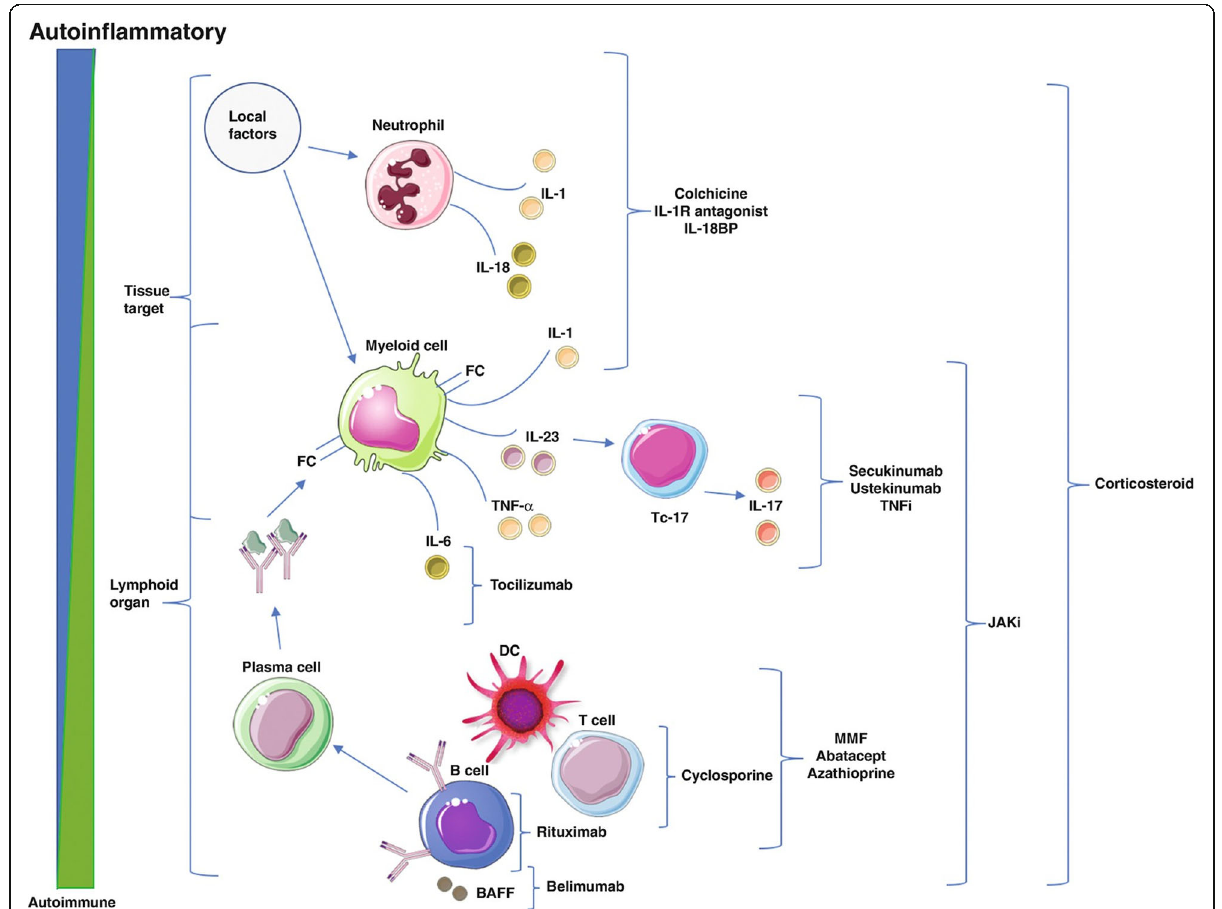
Fig. 3 Autoimmunity and autoinflammation classification is reflected in differential therapeutic targeting. MMF mycophenolate mofetil; BAFF B cell activating factor; IL interleukin; IL-1R IL-1 receptor; IL-18BP IL-18 binding protein; TNF tumor necrosis factor; TNFI TNF inhibitor; JAKI Janus kinase